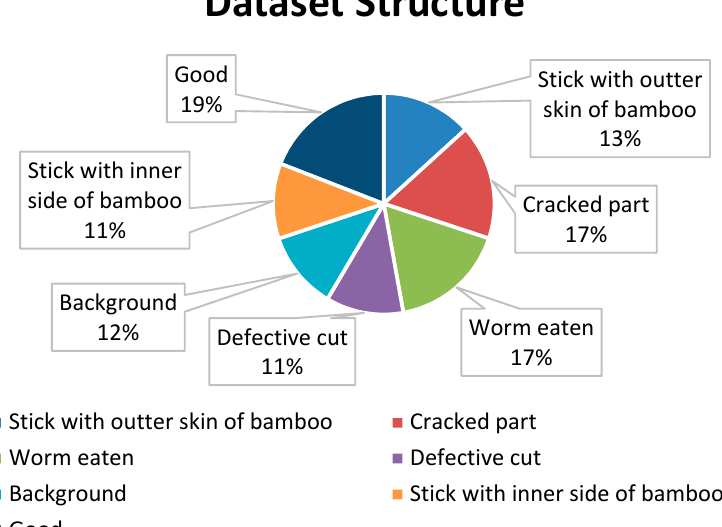
Figure 6. Example of non-qualified bamboo strips class images, from left to right: ( a ) stick with inner side, ( b ) stick with outer skin, ( c ) cracked, ( d ) defective cut, ( e ) worm eaten.